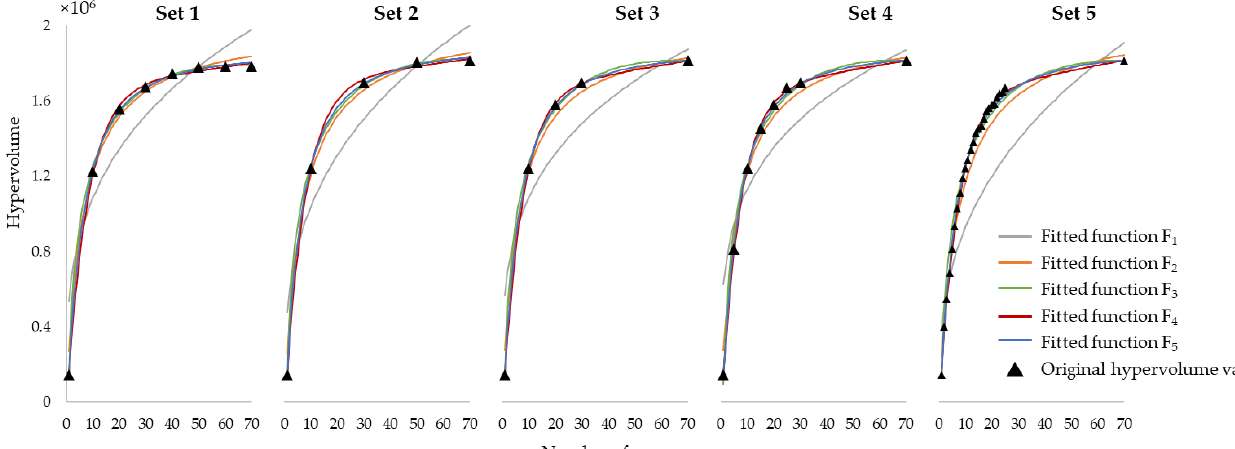
Figure 7. Estimated hypervolume values using different fitted functions F i and different discrete sets of numbers of sensors.